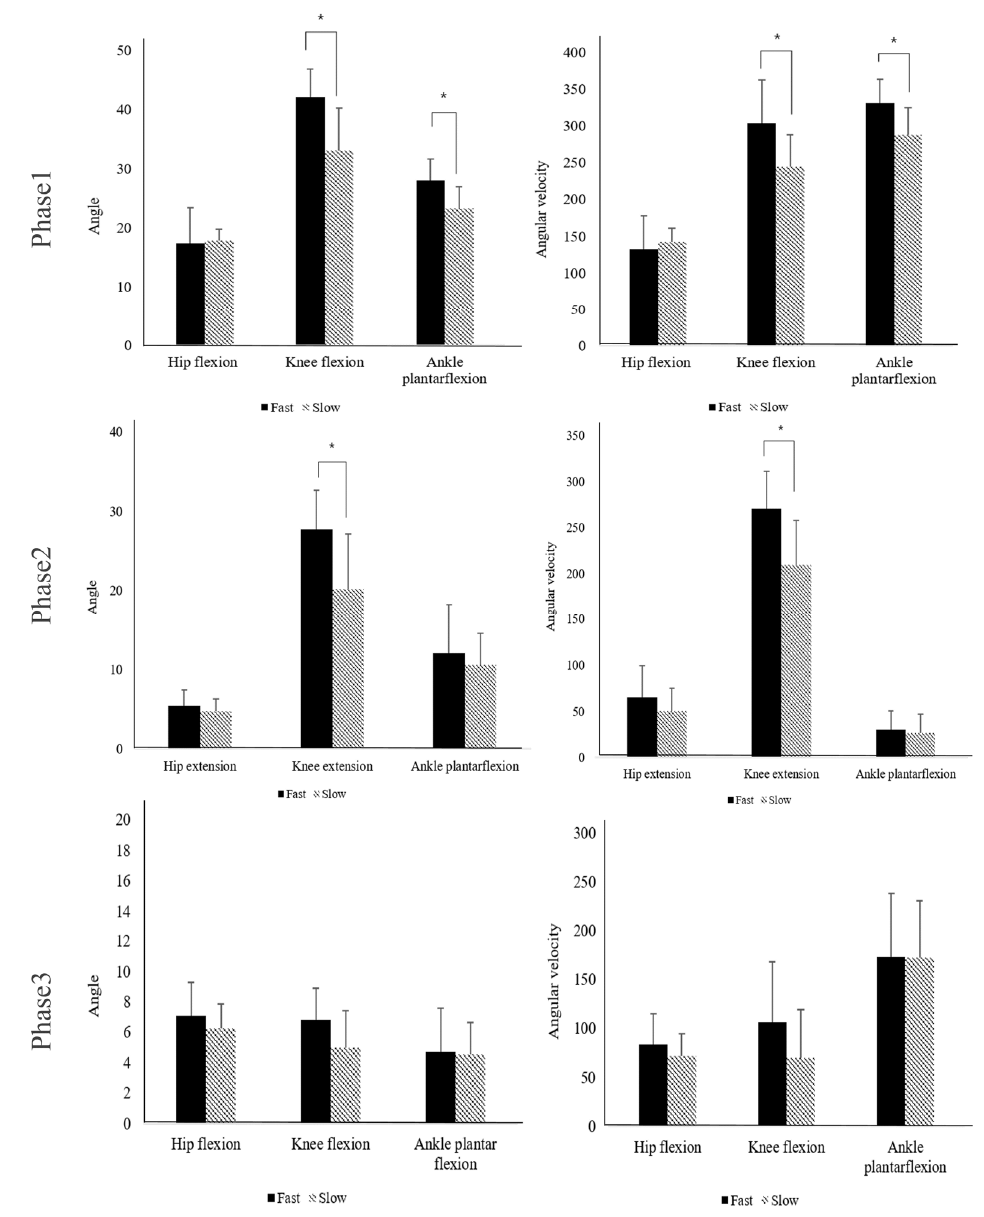
Figure 1. Comparison of joint angle and joint angular velocity between the groups in all phases. * Significant difference in the joint angle between the groups ( p < 0.05).